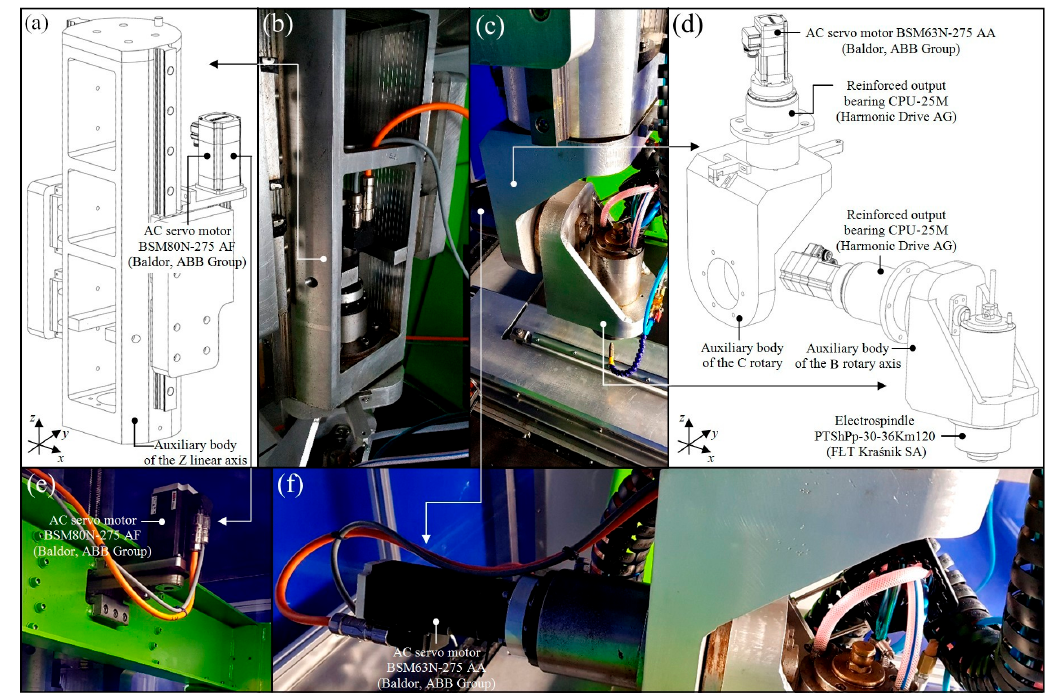
Figure 3. Construction phase of a 5-axis CNC grinding machine for the precision grinding process of the cutting edges of industrial cutting blades: ( a,b ) Auxiliary body of the Z linear axis (axonometric view of the 3D model and construction details); ( c , d ) auxiliary bodies of the C and B rotary axes, respectively (axonometric views of the 3D models and construction details); ( e ) details of AC servo motor BSM80N-275 AF mounting in of the Z linear axis; ( f ) details of AC servo motor BSM63N-275 AA mounting in of the B rotary axis.